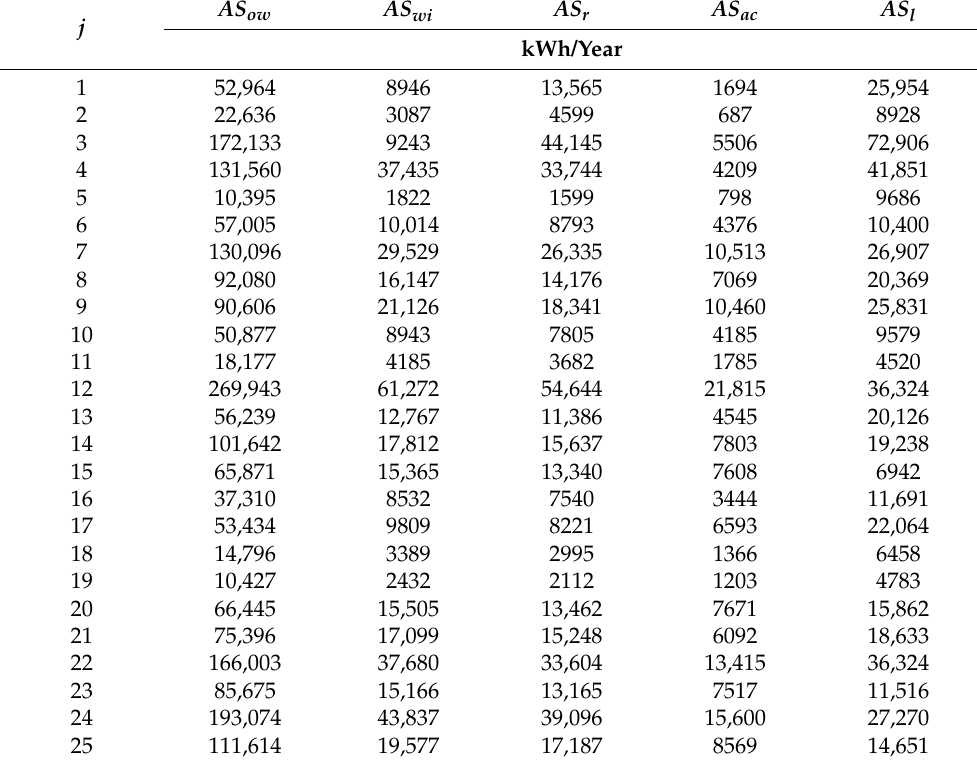
Table A3. Annual saving of energy in kWh/year for individual buildings and energy saving measures considered. AS = annual saving (kWh/year), ow = outer walls insulation, wi = windows